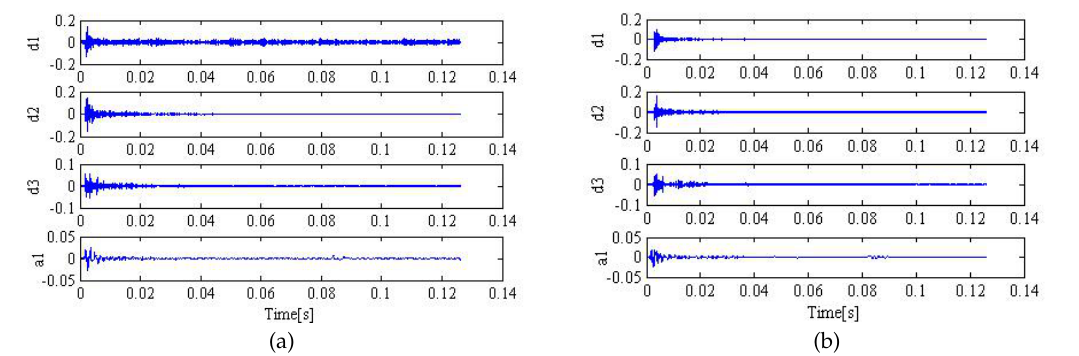
Fig. 7. Decomposition results of non blockage (a) and level I blockage (b) signals